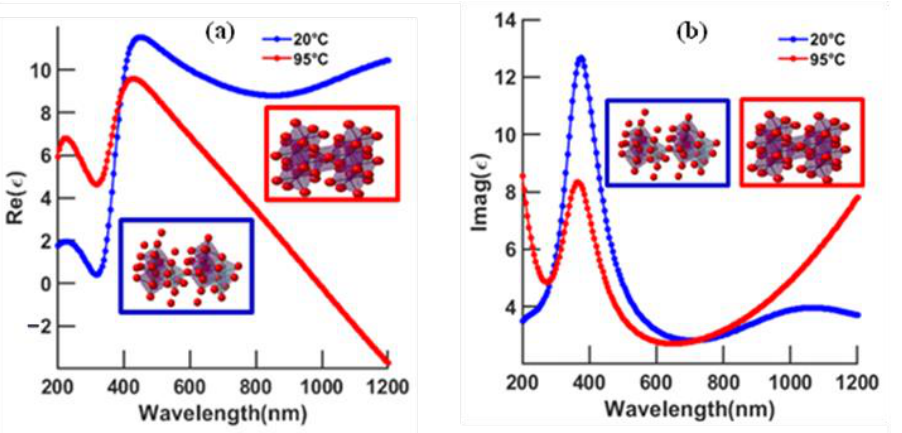
Figure 2. Experimental dielectric function: ( a ) real part and ( b ) imaginary part of VO 2 at 20 ◦ C and 95 ◦ C.